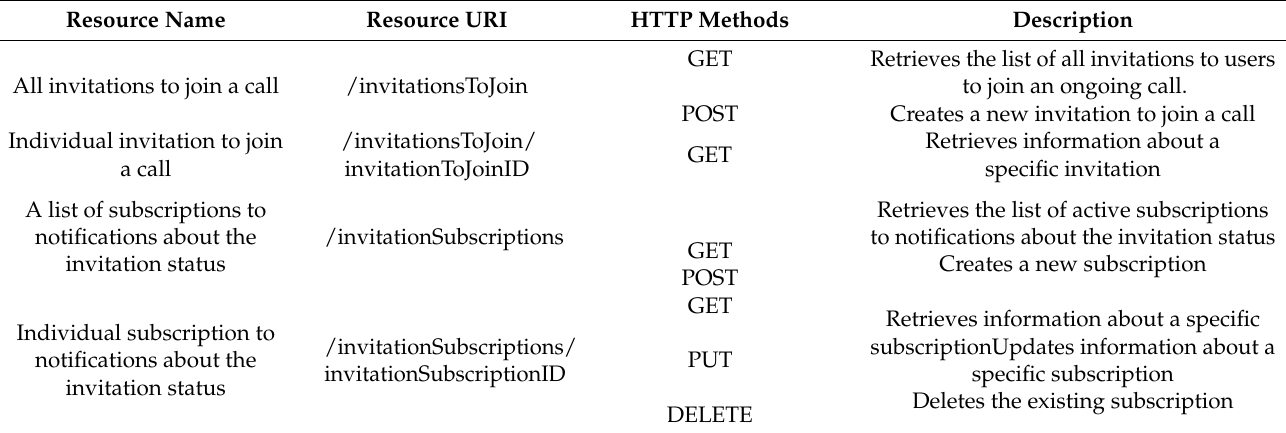
Table 2. IUM service resources and methods.